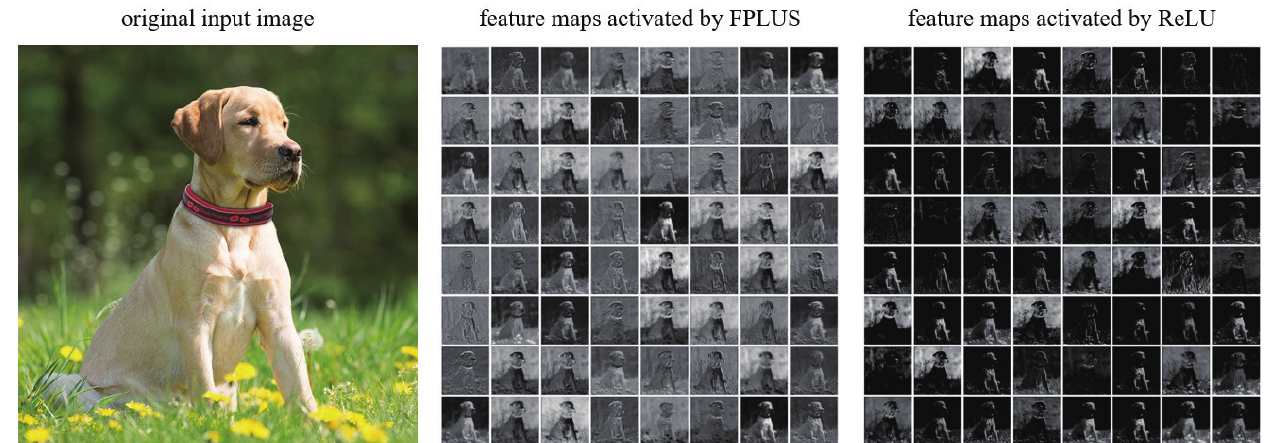
Figure 8. Visualization of feature maps produced by ResNet18’s first activation layer, whose dimen- sion is 64 channels generated by previous convolutional layer with batch normalization. They are presented in 8 × 8 grids and the format is in original grayscale. Comparison displays the impact of two different activation